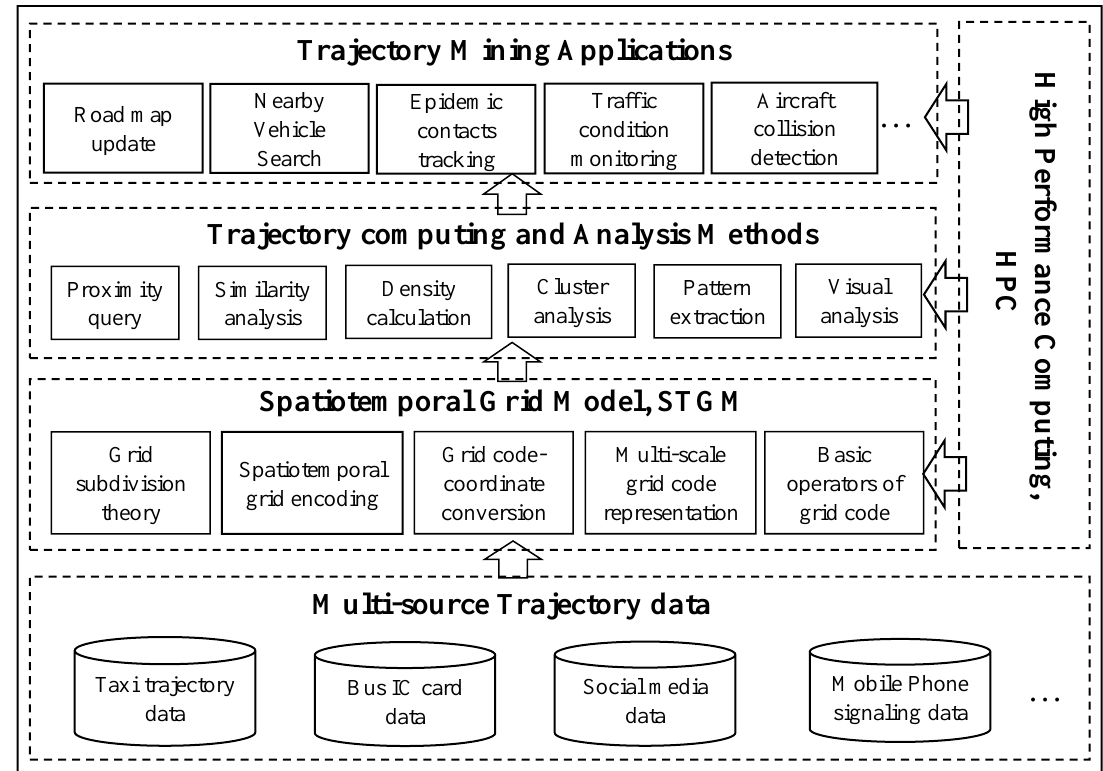
Figure 1. Technology framework of trajectory data management and analysis based on the STGM